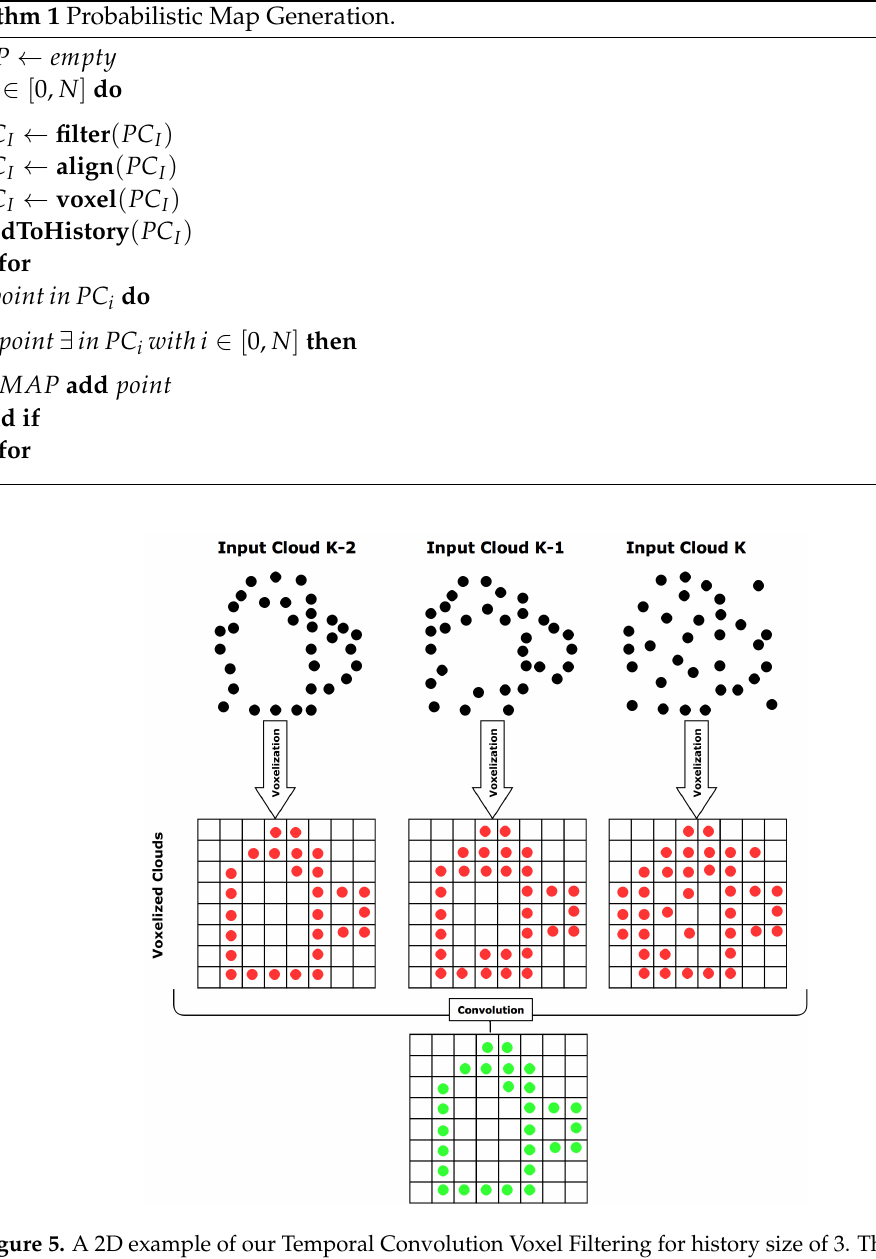
Figure 5. A 2D example of our Temporal Convolution Voxel Filtering for history size of 3. The method checks the occupancy of each voxel through the history of point clouds and only voxels occupied in the entire history are passed through the